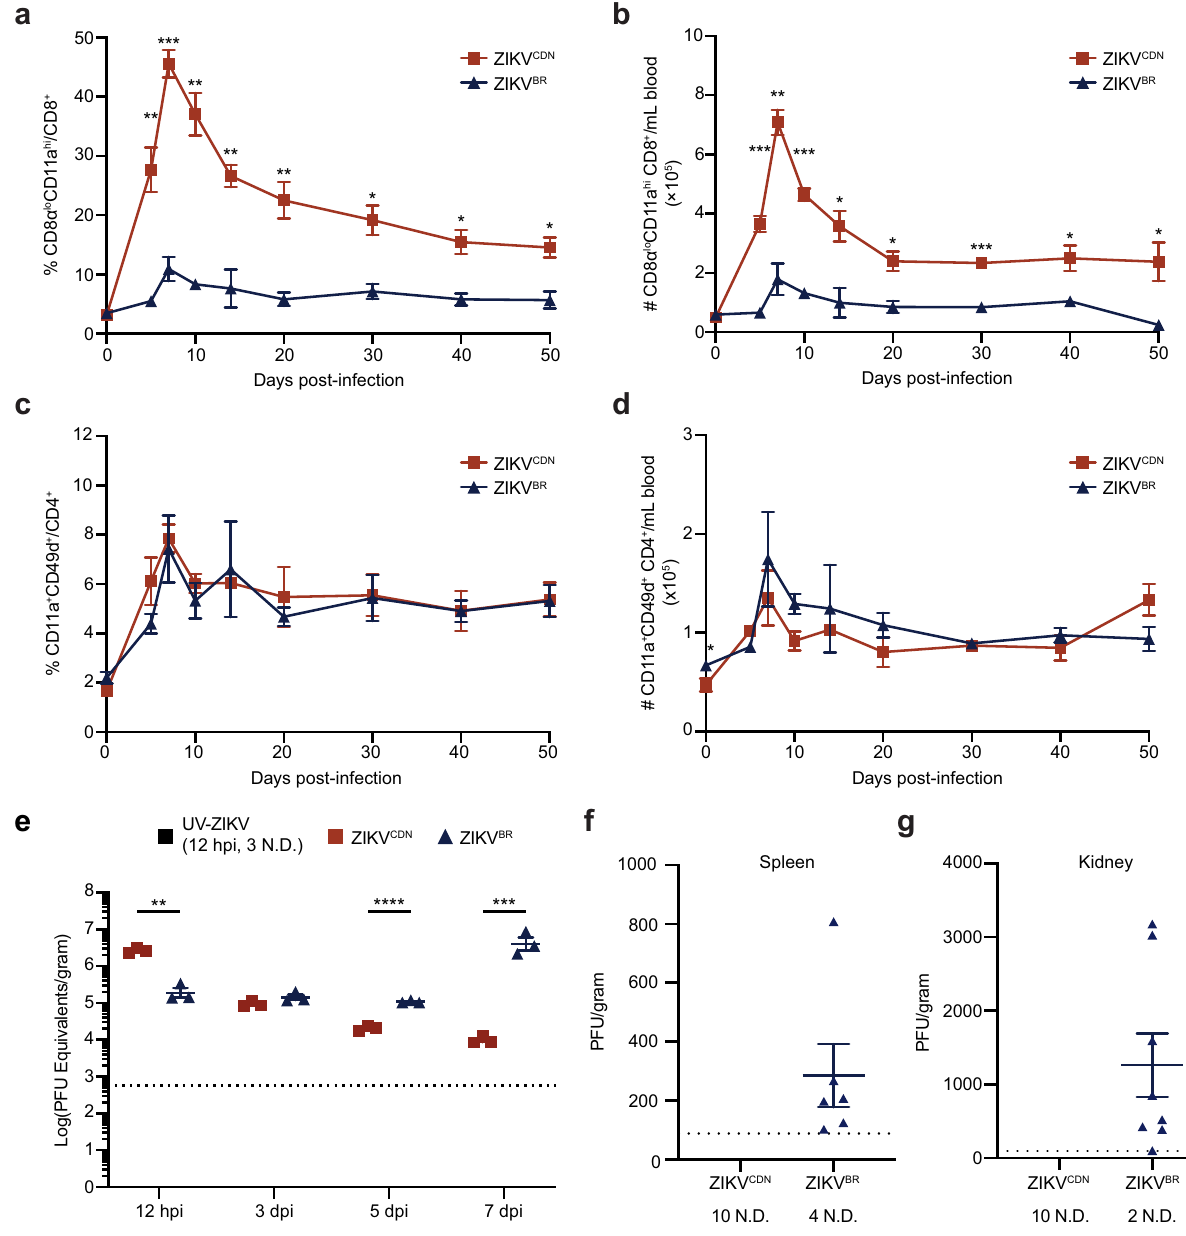
Fig. 1 Reduced CD8 T cell response to ZIKV BR is associated with virus detection at later time points following infection. a , b Frequency ( a ) and number ( b ) of CD8 α lo CD11a hi CD8 T cells in the peripheral blood of mice at indicated dpi with ZIKV CDN or ZIKV BR . Data are representative of two independent experiments with n = 3 mice per group, sampled repeatedly at indicated time points. Data were analyzed by two-tailed, unpaired Student ’ s t -test at each time point. In a day 5 p = 0.0041, day 7 p = 0.0004, day 10 p = 0.0015, day 14 p = 0.0067, day 20 p = 0.0073, day 30 p = 0.0132, day 40 p = 0.0137, day 50 p = 0.0157. In b day 5 p = 0.0004, day 7 p = 0.0014, day 10 p = 0.0003, day 14 p = 0.0218, day 20 p = 0.0169, day 30 p = 0.0002, day 40 p = 0.0371, day 50 p = 0.0327. c , d Frequency ( c ) and number ( d ) of CD11a + CD49d + CD4 T cells in the peripheral blood of mice at indicated dpi with ZIKV CDN or ZIKV BR . Data are representative of two independent experiments with n = 3 mice per group, sampled repeatedly at indicated time points. Data were analyzed by two-tailed, unpaired Student ’ s t -test at each time point. In d day 0 p = 0.0407. e Viral RNA was quanti fi ed in the spleen using RT-qPCR analysis. Data are presented as PFU equivalents per gram of tissue after comparison to a standard curve of C t value versus log 10 (PFU) for each isolate. Mice were sacri fi ced 12 hpi and 3, 5, and 7 dpi with ZIKV CDN or ZIKV BR , or following mock-infection or injection with UV-ZIKV (12 hpi only). Data are representative of three independent experiments, with n = 3 mice per group at each time point. Data were analyzed by two-tailed, unpaired Student ’ s t -test at each time point, 12 hpi p = 0.001, 5 dpi p = 0.000079, 7 dpi p = 0.00014. f , g Viral burden in the spleen ( f ) and kidney ( g ) were quanti fi ed via plaque assay 7 dpi with each ZIKV isolate. N.D. indicates no data recorded above the LOD (dotted line). Data are pooled from two experiments with n = 5 mice per group. All data are shown as mean ± SEM and * p < 0.05, ** p < 0.01, *** p < 0.001, and **** p < 0.0001. Red squares = ZIKV CDN -infected mice, blue triangles = ZIKV BR -infected mice, black squares UV-ZIKV-injected mice. Source data are provided as a Source Data fi